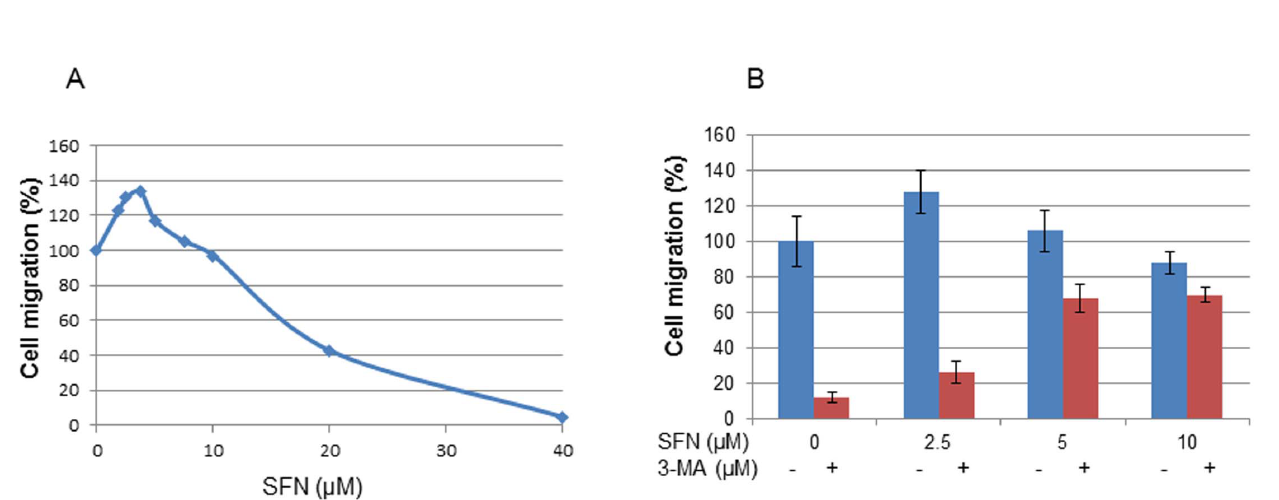
Fig. 2. Effects of SFN and 3-MA on cell migration. A: After starvation overnight, bladder cancer T24 cells were treated with SFN at the concentrations indicated for 24 h, cell migration was measured by a cell migration assay using the ThinCert cell culture inserts (Greiner Bio-One Ltd.). Each bar represents the mean ¡ SD of 3 replicates. B: Effect of pre-treatment of 3-MA on cell migration. DMSO (0.1% was used as a control). Statistical significance from the control, *p , 0.05, or **p , 0.01.